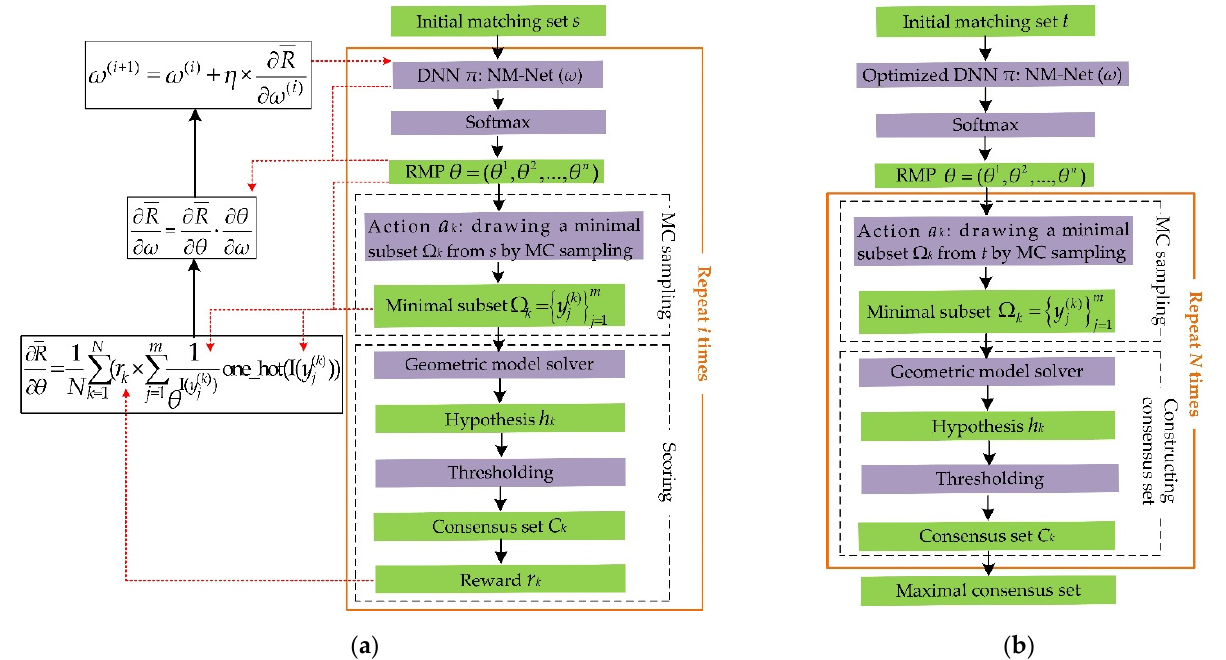
Figure 4. Training and predicting pipelines of ULMR. ( a ) Training pipeline, ( b ) Predicting pipeline.